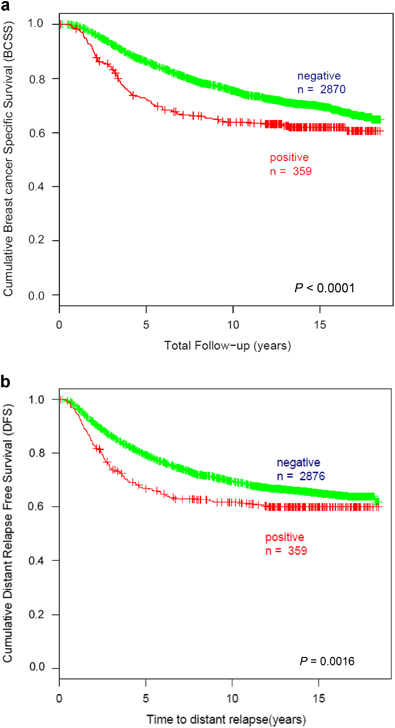
αB-crystallin expression is associated with worse breast cancer-specific survival (BCSS) and distant relapse-free survival (DFS) in univariable analyses. (a) Kaplan–Meier analysis of BCSS based on αB-crystallin expression. 10-year BCSS was 64% for αB-crystallin-positive cases (n=359, number of events=133) versus 75% for αB-crystallin-negative cases (n=2,870, number of events=809), P<0.0001 by log-rank test. (b) Kaplan–Meier analysis of DFS based on αB-crystallin expression. 10-year DFS was 62% for αB-crystallin-positive cases (n=359, number of events=139) versus 70% for αB-crystallin-negative cases (n=2876, number of events=915), P=0.0016 by log-rank test.